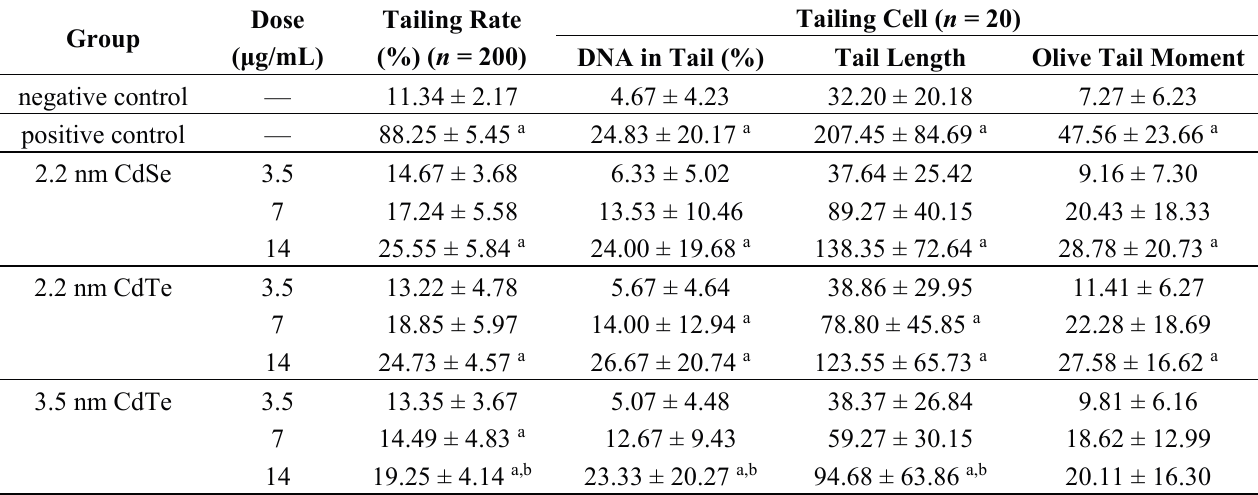
Table 2. Changes in the levels of DNA damage (tail length, % DNA in tail, tail moment and olive tail moment) in L929 mouse